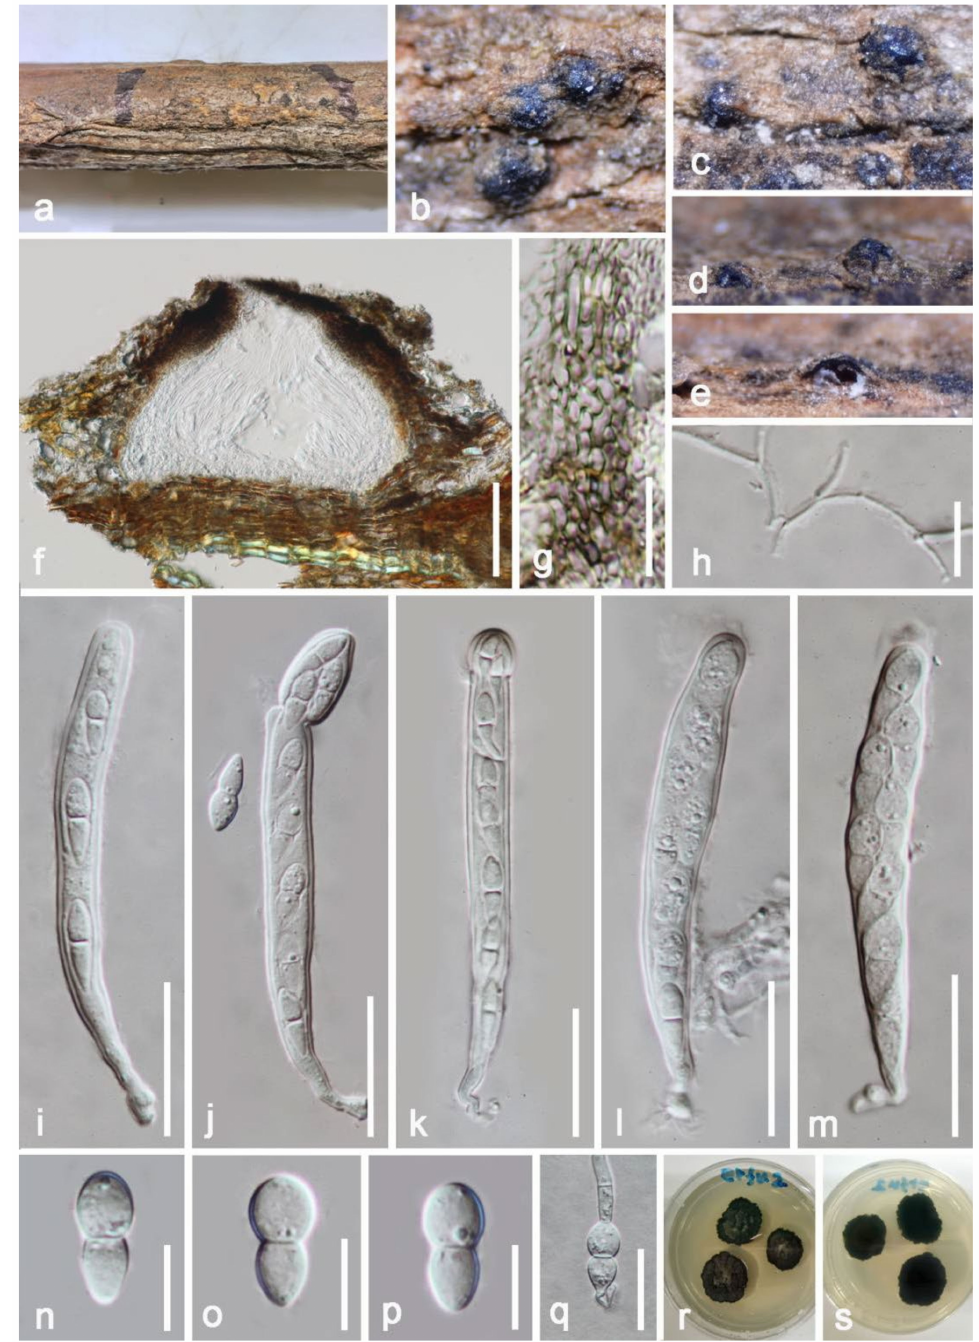
Figure 7. Neomassaria hongheensis (HKAS 122191, holotype). ( a ) Appearance of ascomata on host substrate; ( b – d ) close-up of substrate; ( e , f ) vertical section of ascoma; ( g ) peridium; ( h ) pseudopa- raphyses; ( i – m ) asci; ( n – p ) ascospores; ( q ) germinated ascospore; ( r , s ) colonies on PDA. Scale bars: ( f ) = 100 µ m; ( i – m ) = 30 µ m; ( q ) = 20 µ m; ( g , n ) = 15 µ m; ( n – p ) = 10 µ m. Parabambusicolaceae Kaz. Tanaka and K. Hiray., Studies in Mycology 82: 115